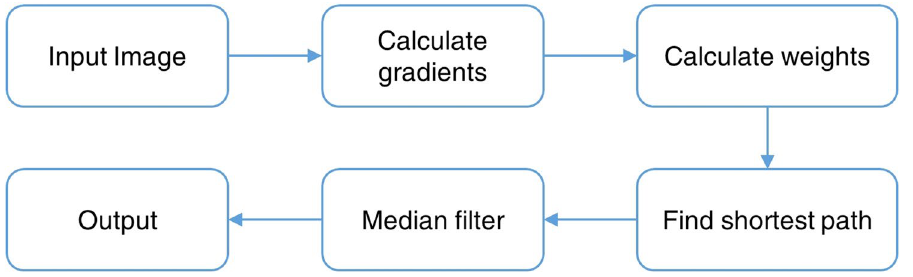
Figure 4. The flowchart of the graph-based image segmentation for layered